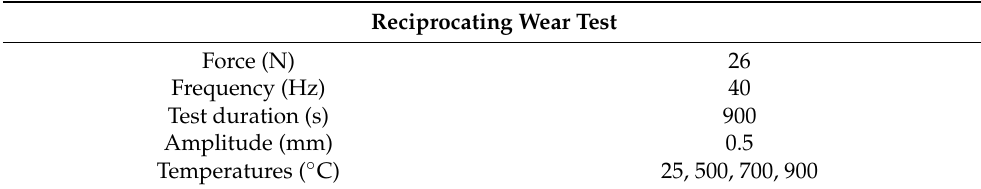
Table 3. Parameters for high-temperature wear